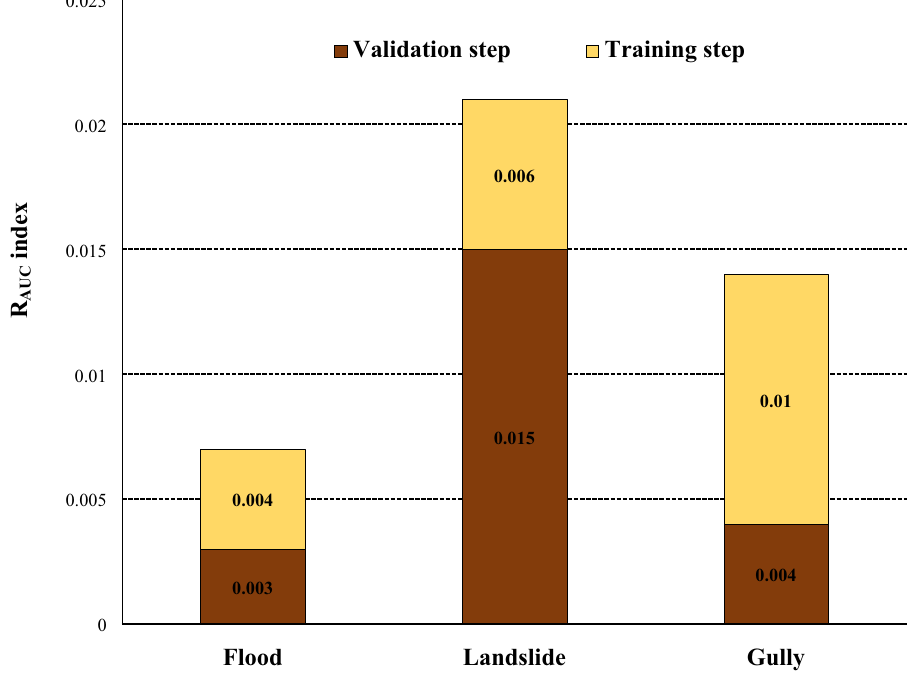
Figure 7. Robustness of the MaxEnt model in training and validation steps based on AUC.